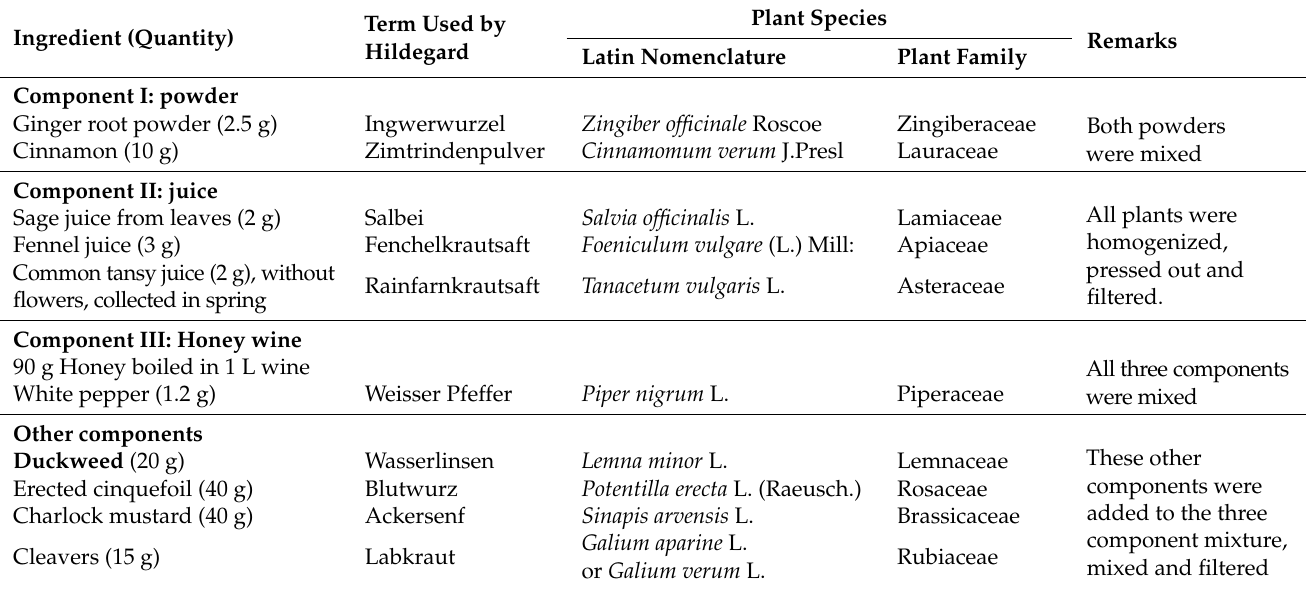
Table 2. Ingredients of duckweed elixir as per the protocol of Hildegard von